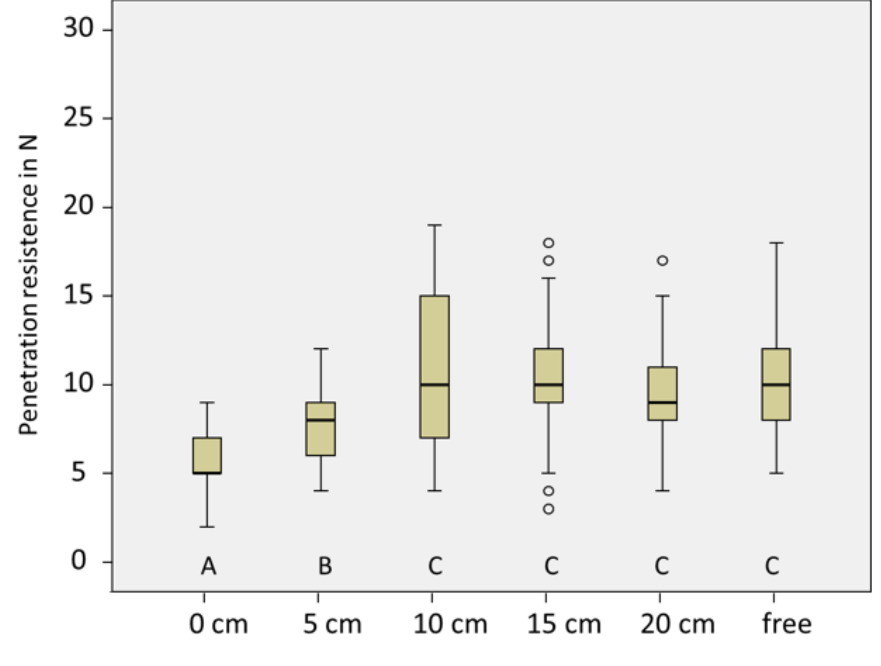
Figure 5. Penetration resistance (N) and standard deviation for different protection levels of the rod (l free ) in silty soil with gravimetric water content of 12%. A, B, and C are markers for different homogeneous subgroups at a significance level of 5%.